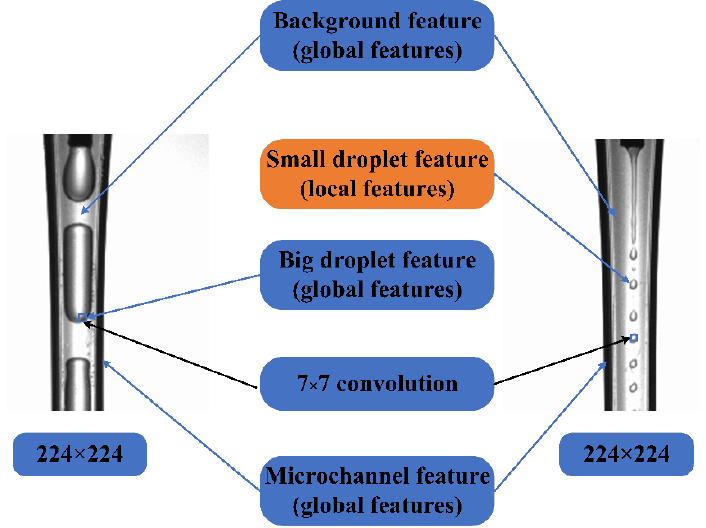
Figure 10. Local features and global features of slug and jetting images.